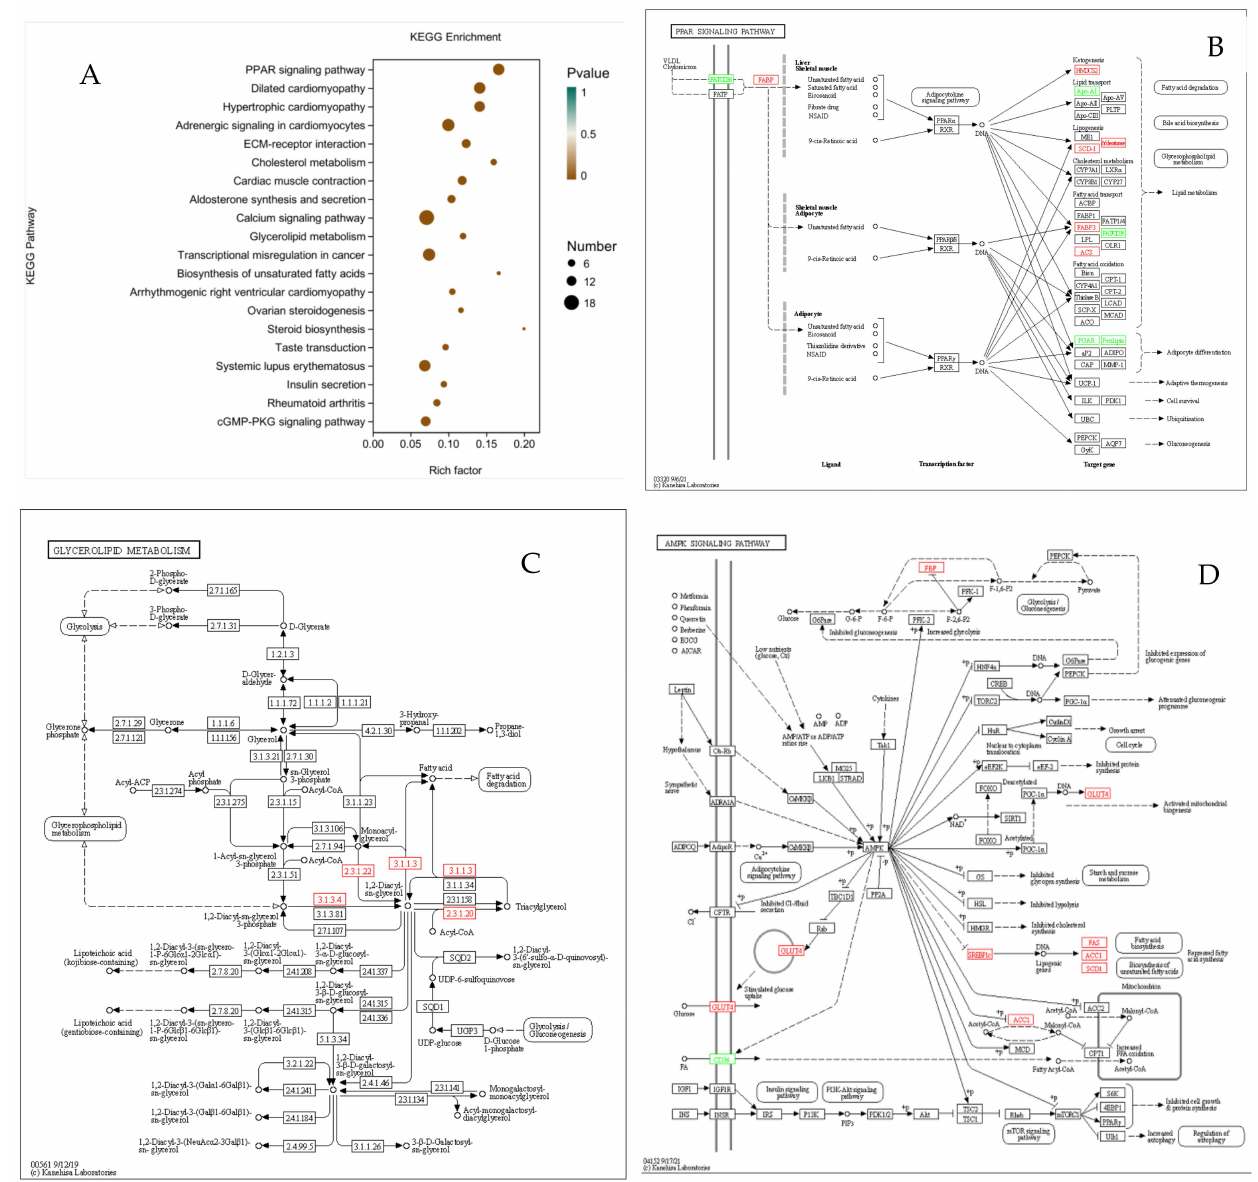
Figure 9. KEGG enrichment analysis of differentially expressed genes (DEGs) after overexpression of DGAT2. ( A ) KEGG enrichment factor map. ( B ) KEGG functional annotation of DEGs involved in the PPAR signaling pathway. ( C ) KEGG functional annotation of DEGs involved in the glycerophos- pholipid metabolic pathway. ( D ) KEGG functional annotation of DEGs involved in the biosynthetic pathway of unsaturated fatty acids. Red rectangles indicate DEGs significantly upregulated (log fold change > 1, false discovery rate (FDR) < 0.001); green rectangles indicate DEGs significantly downregulated (log fold change > 1, FDR < 0.001) in BSCs infected with Ad-DGAT2 compared with control